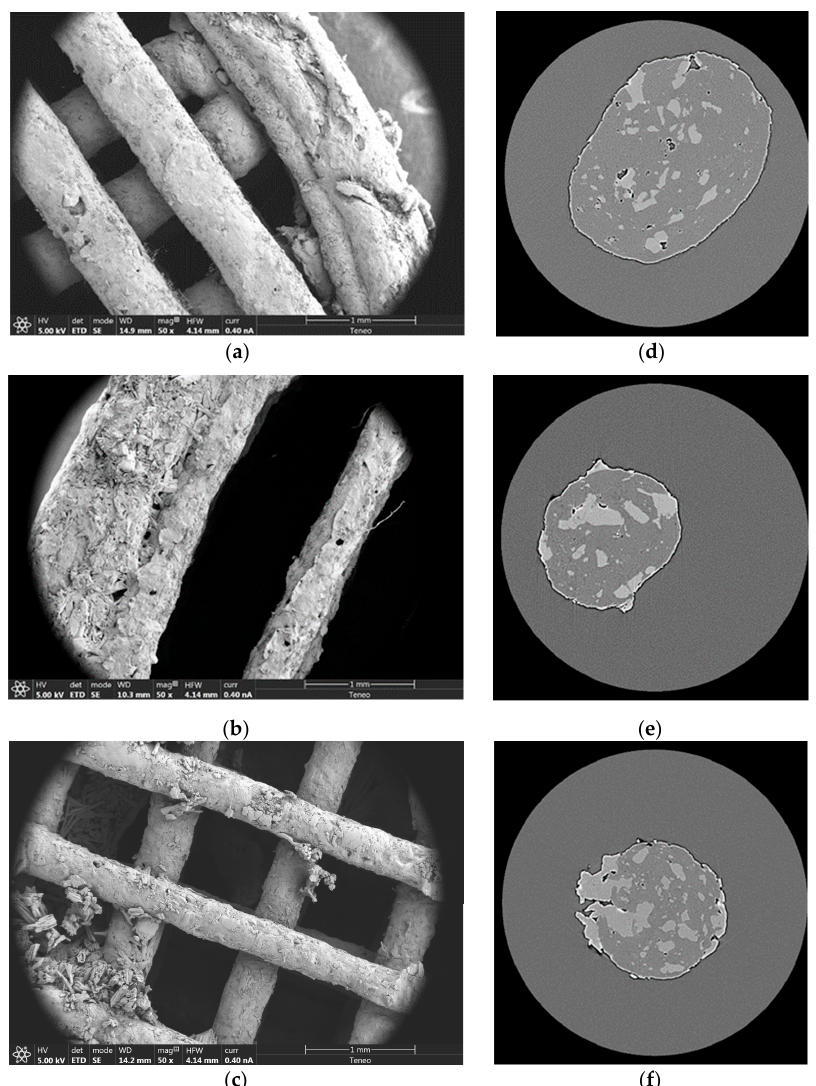
Figure 6. SEM images at 50X of the inner structure of the systems printed with 20% ( a ), 30% ( b ), and 50% ( c ) drug loading, and images made with X-ray tomography of the cross-section of the strands of the same drug percentages (20% ( d ), 30% ( e ), and 50% ( f )).